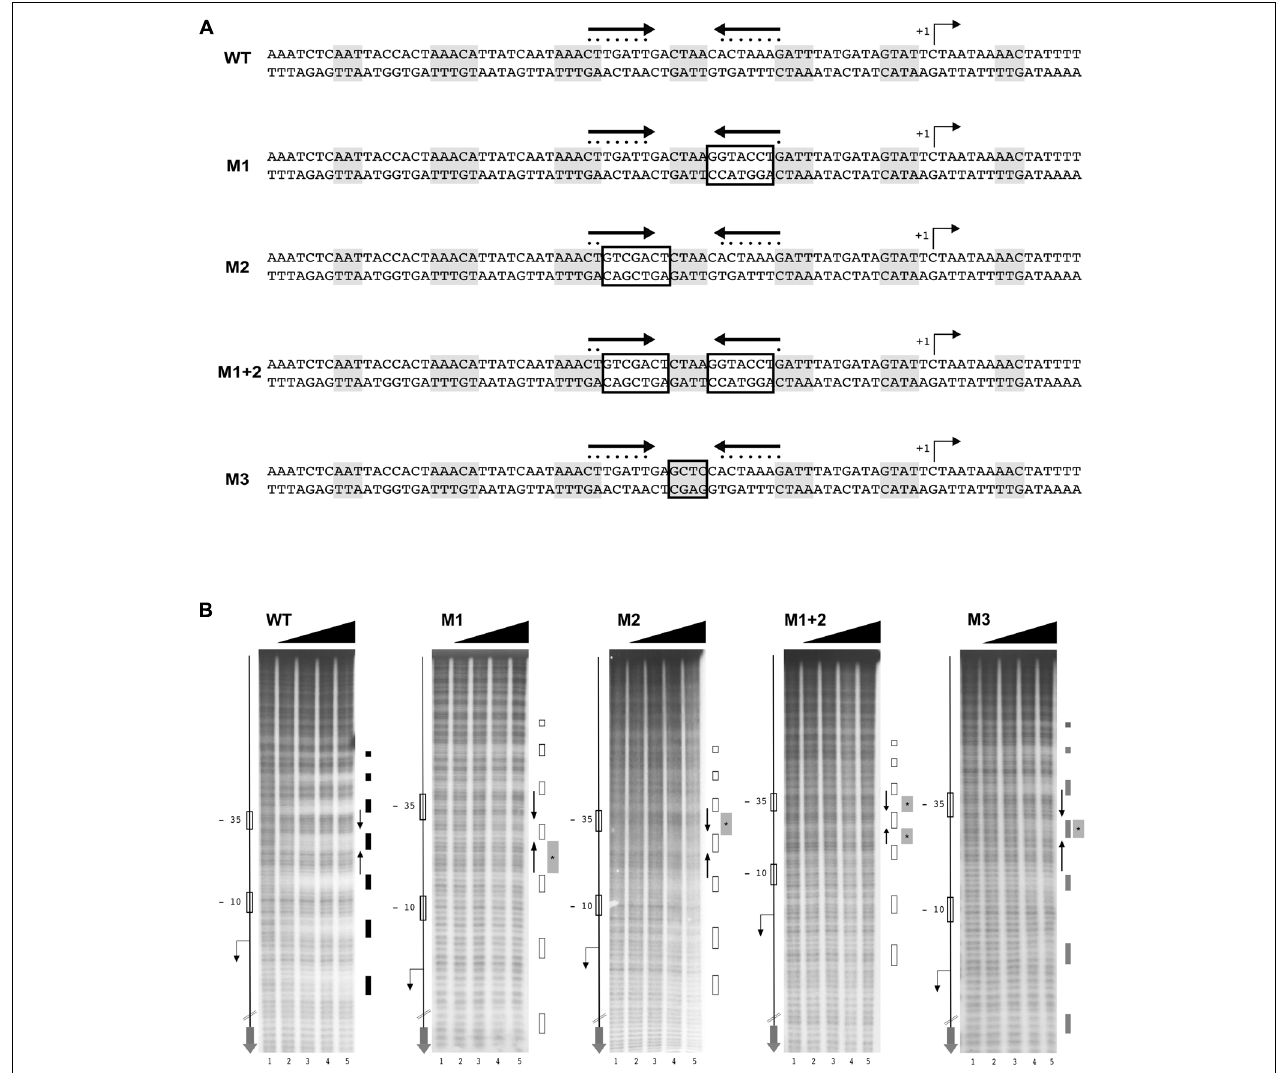
FIGURE 4 | The HAIR-like motif is essential for HspR binding to DNA. (A) Schematic representation of wild type and four different P cbp mutant probes, in which one (M1 and M2) or both arms (M1 + 2) of the inverted repeat and the protected region between these sequences (M3) have been mutagenized by base substitution. HspR protected regions on P cbp are shaded in gray and the inverted repeat sequences (HAIR-like motif) is represented by converging black arrows and their nucleotides marked with dots. In each DNA probe, mutagenized nucleotides are boxed. (B) From left to right, hydroxyl-radical footprint experiments on wild type and the indicated mutants of the P cbp promoter region. Symbols are as described in the legend to Figure 3A . Wild type (WT) and indicated mutants DNA probes were incubated with increasing amounts of purified HspR protein and submitted to hydroxyl-radical digestion (see legend to Figure 3 ). Black, gray, and empty boxes to the right of each panel denote strong, weak, and loss of protection by HspR, respectively. Black converging arrows to the right of each panel mark the positions of the HAIR-like inverted repeat sequences, while gray boxes with an internal asterisk indicate the mutagenized